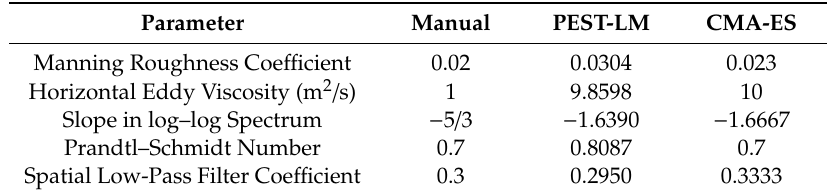
Table 2. Calibrated values of the model parameters using three methods. CMA-ES: covariance matrix adaptation evolution strategy, LM: